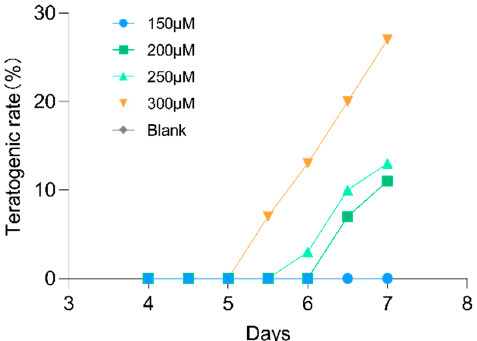
Figure 11. Developmental toxicity of lotusine to zebrafish larvae ( n = 3, 30 larvae per group). No death appeared in blank controls. death appeared in blank